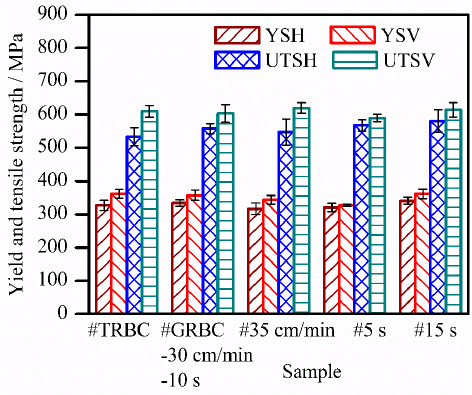
Figure 12. Horizontal and vertical yield and tensile strengths of different samples. (TRBC and GRBC represent transient and gradual reduction of bottom current, respectively).